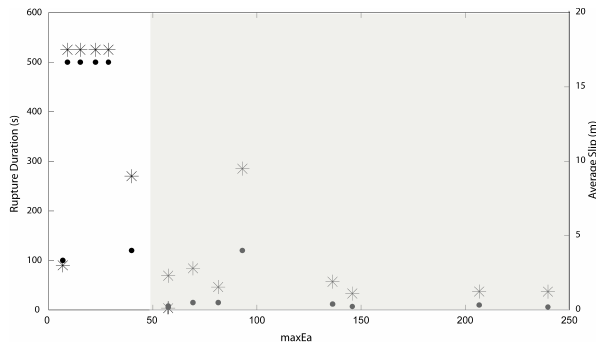
Fig. 6. The plot shows the average fault slip (as star), “max E a ” and rupture duration (as dots) for the events in Table